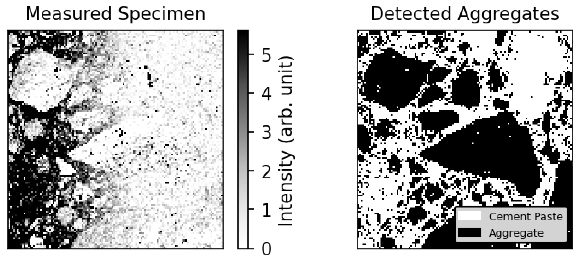
Figure 11. ( Left ) Heatmap from the chlorine channel of the scanned area (see Figure 10). ( Right ) Detected aggregates with